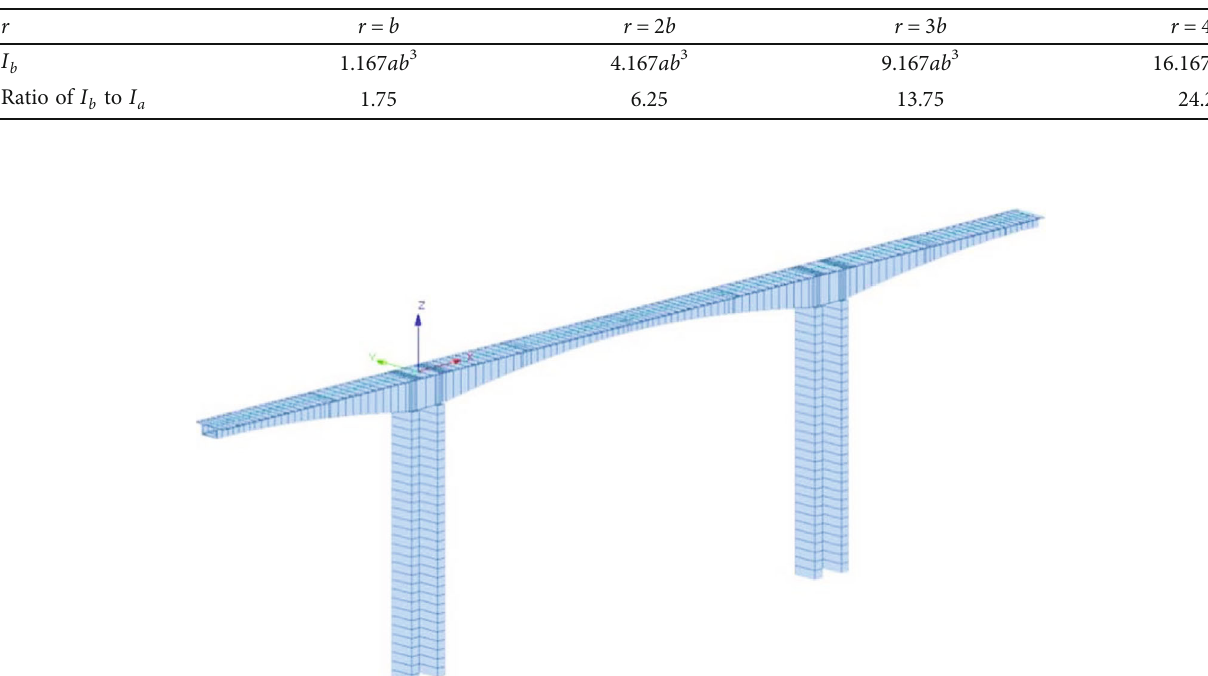
Table 1: Comparison of thrust sti ff ness of single-limb thin-wall pier and double-limb thin-wall pier.